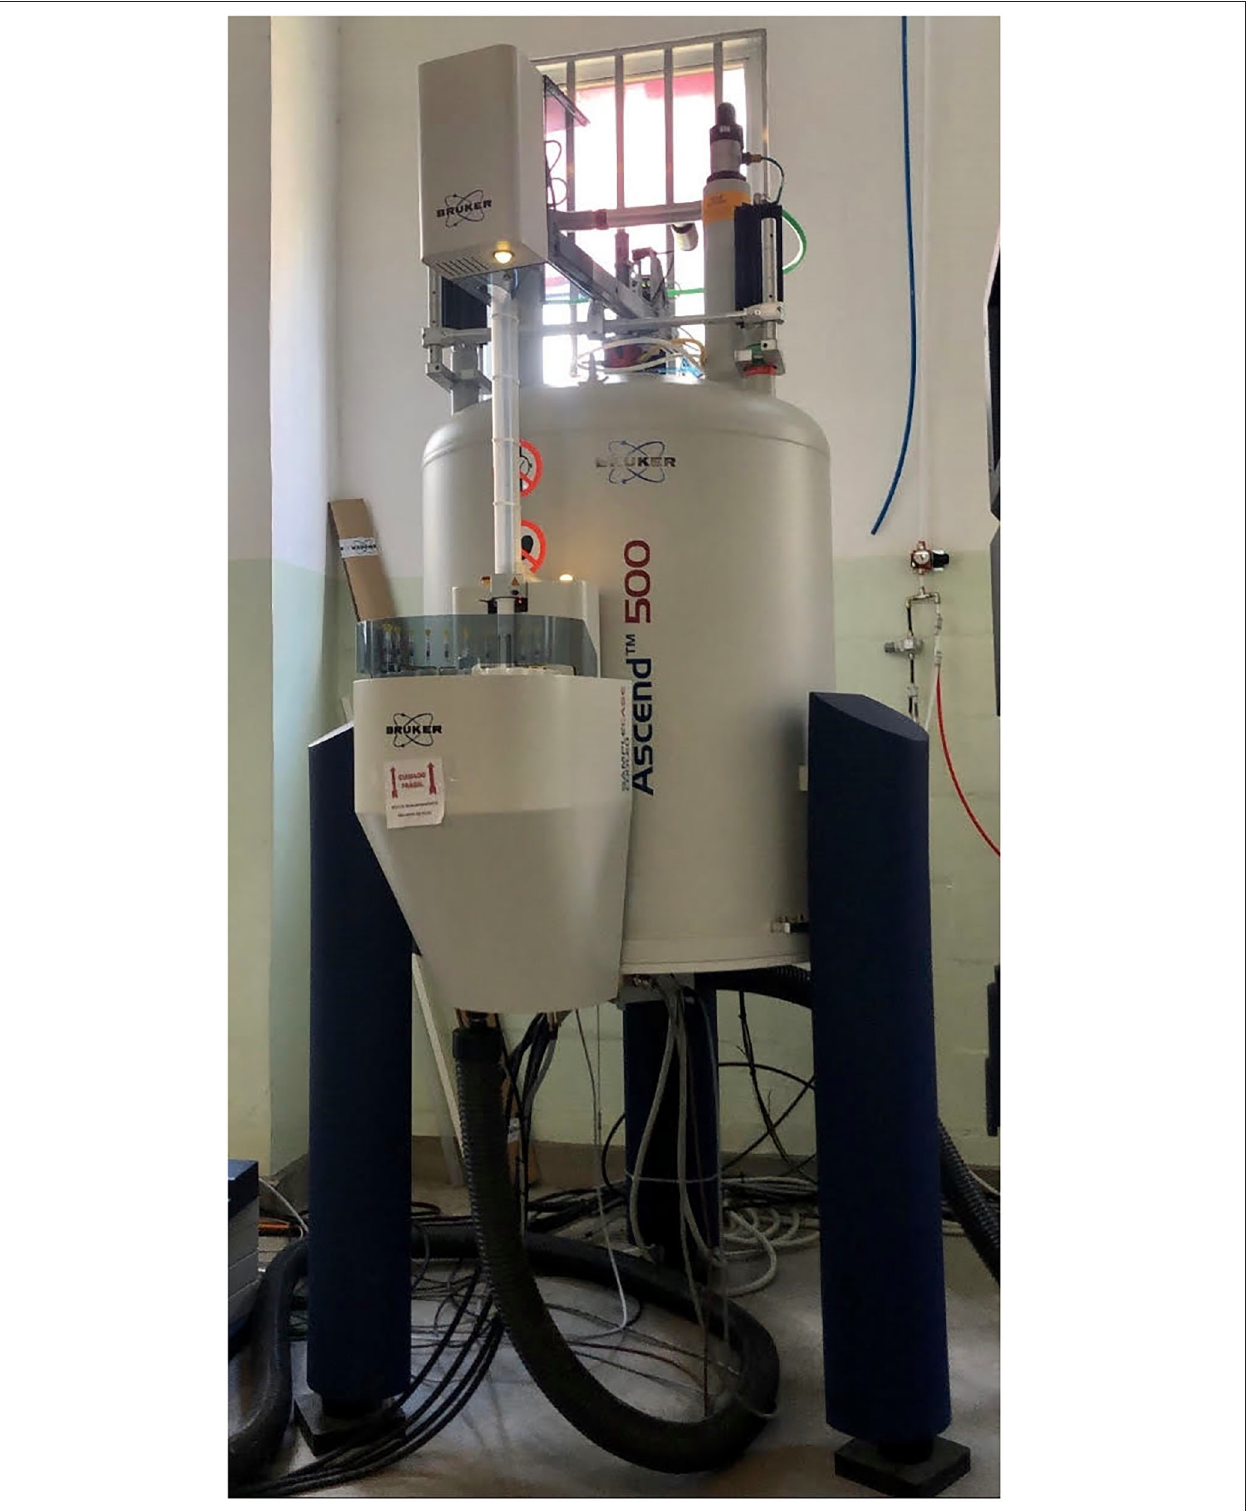
FIGURE 1 | Photograph of the 500-MHz NMR spectrometer (Bruker Biospin, Rheinstetten, Germany) in which the metabolomic analyzes of the saliva of infants in the pre-dental period before and after oral mucosa hygiene procedures were performed.